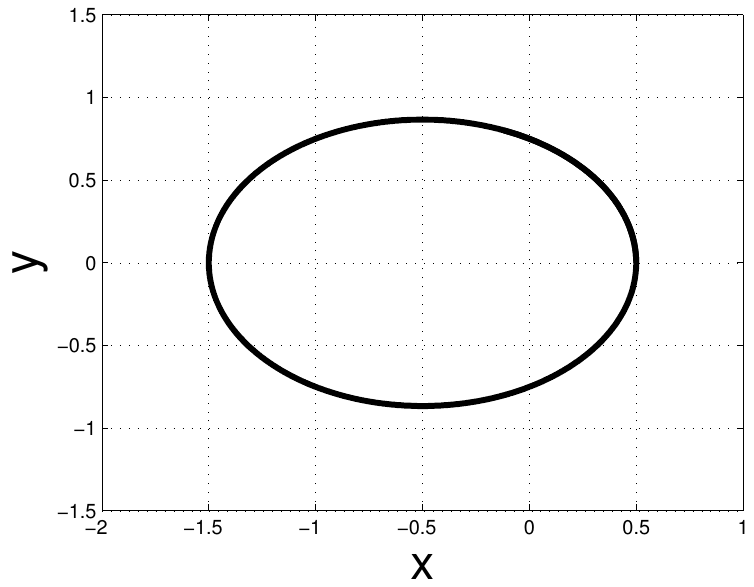
Figure 1. The reference solution for Kepler’s problem computed by integrating Equation (90) until the time T = 7 using Verner’s method with the time step h = 2 × 10 − 7